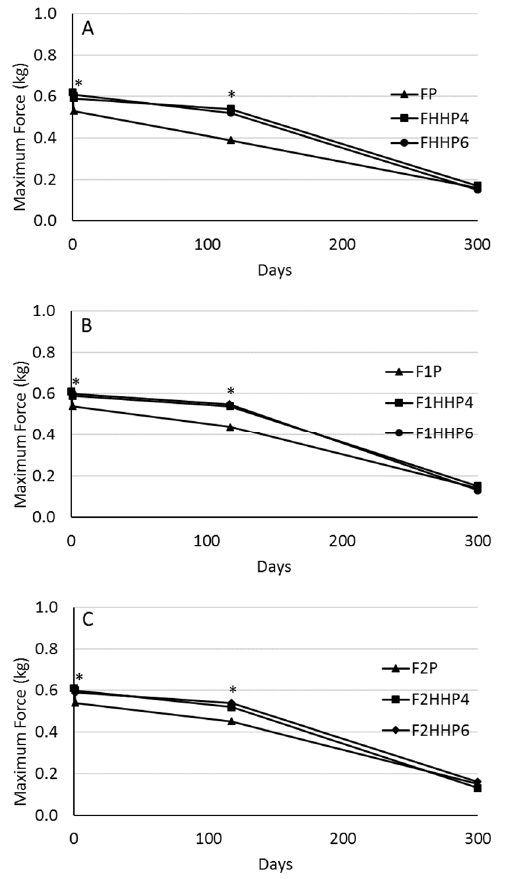
Figure 2. Hardness evolution of table olives during the storage process. ( A ): control olives, without inoculation or OLE addition (FP, pasteurized; FHHP4 and FHHP6, treated with HHP); ( B ): olives with OLE and non-inoculated (F1P, pasteurized; F1HHP4 and F1HHP6, treated with HHP); ( C ): olives inoculated with S. cerevisiae strain and added with OLE (F2P, pasteurized; F2HHP4 and F2HHP6, treated with HHP). *: indicates statistically significant differences (Tukey’s Test, p < 0.05) among conservation treatments for the same storage time.